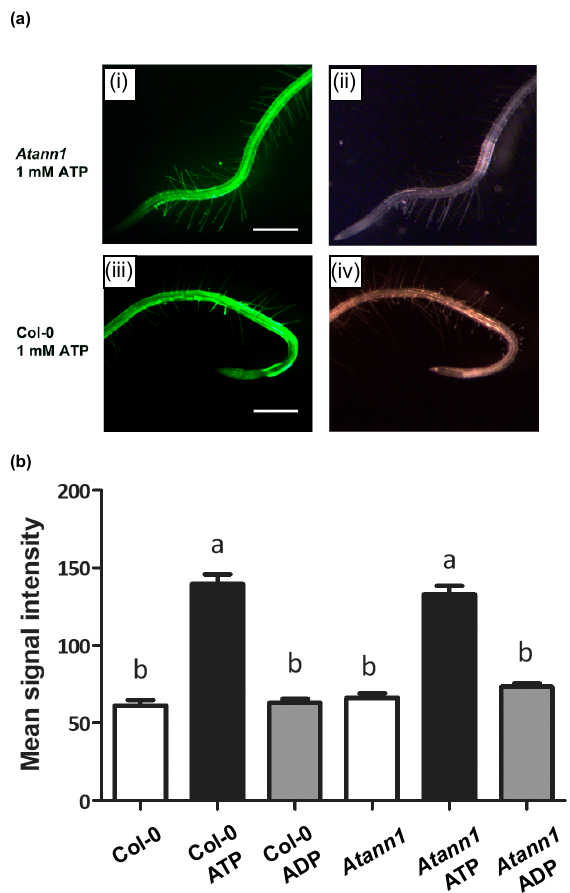
Figure 6. eATP-induced intracellular ROS accumulation at the root apex at higher resolution. ( a ) CM-H 2 DCFDA fluorescence from (i) a representative Atann1 root exposed to 1 mM eATP and (ii) corresponding bright field image. (iii) A representative Col-0 root after exposure to 1 mM eATP and (iv) corresponding bright field image. ( b ) Mean (± SEM) of fluorescence pixel intensity at root apices under control conditions and after 30 s exposure to 1 mM eATP (Col-0 n = 48; Atann1 n = 68) or 1 mM ADP (Col-0 n = 32; Atann1 n = 38). Both genotypes responded significantly to eATP but not eADP ( p < 0.001; ANOVA with Dunnett’s post-hoc test). Scale bar = 2 mm. Different lower-case letters indicate a significant difference between means ( p < 0.05).